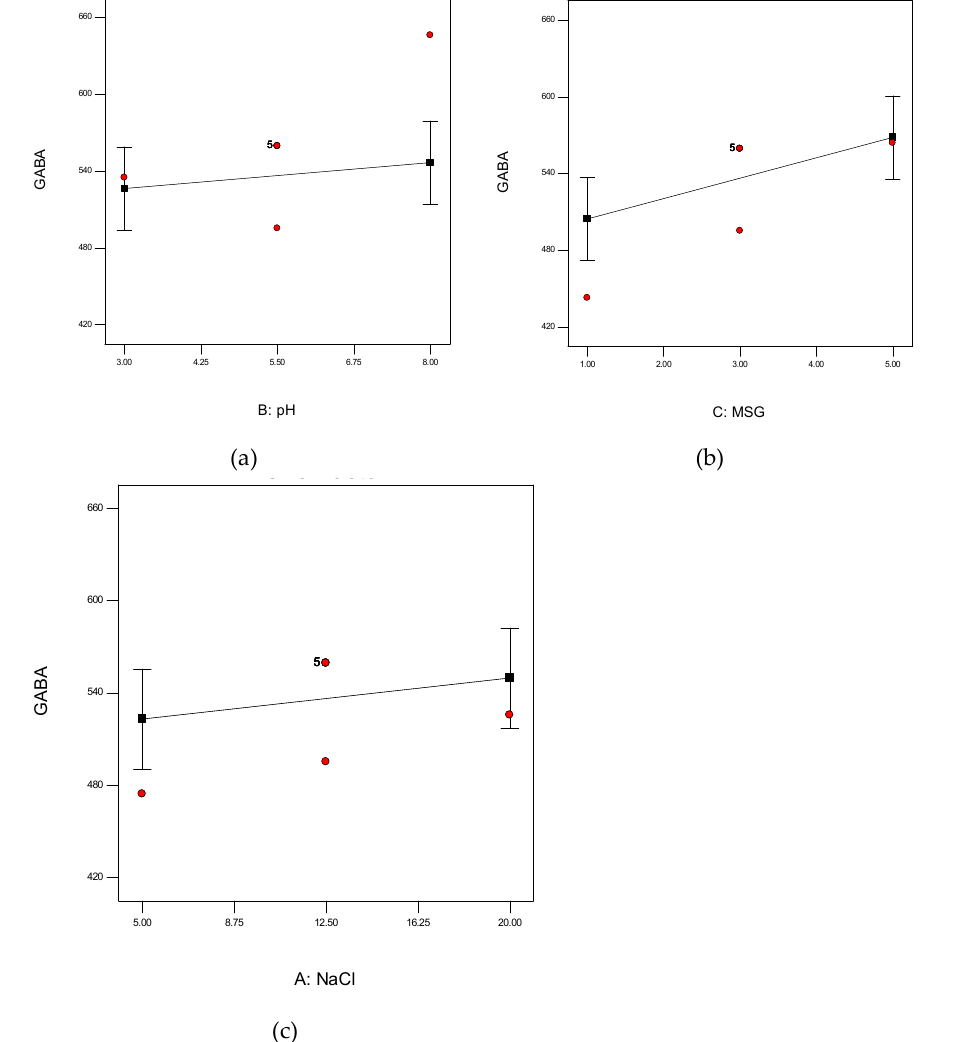
Figure 3. One-factor profile demonstrating ( a ) pH, ( b ) MSG concentration (g/L), and ( c ) NaCl (%) effects on GABA yield by THSK.